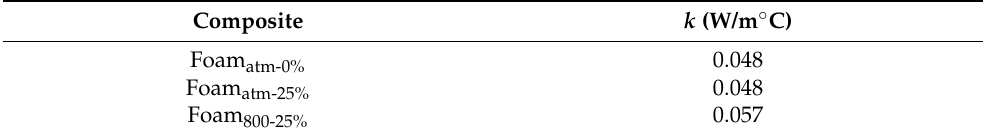
Table 3. Thermal conductivity of the synthetized composite foams.